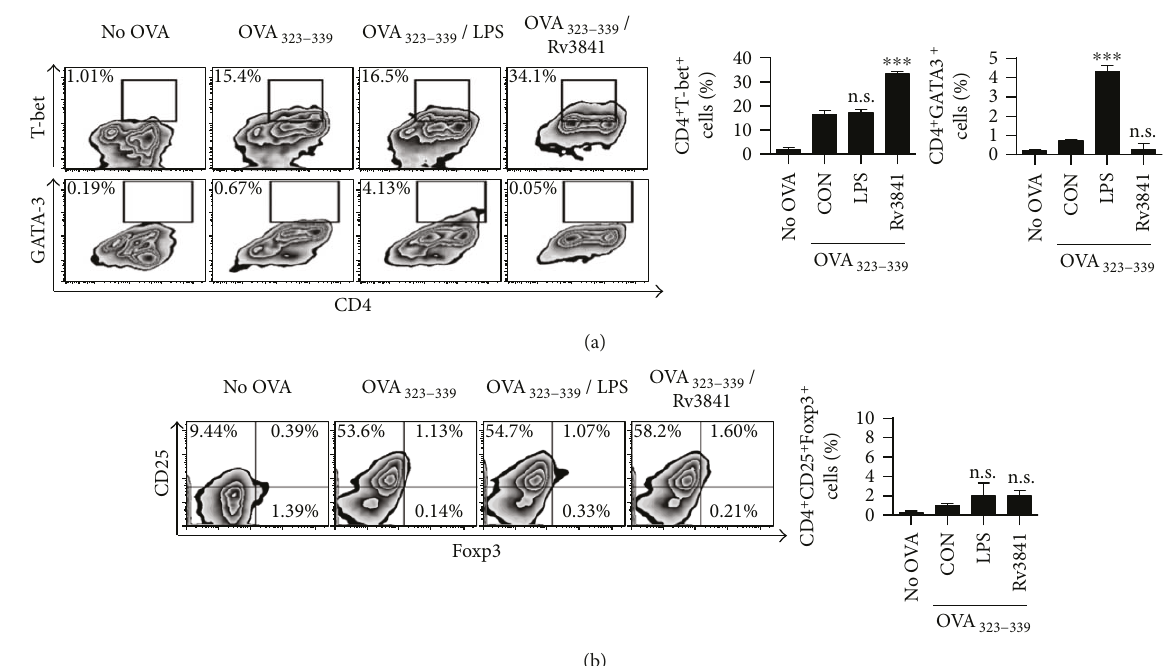
Figure 5: Rv3841-treated DCs stimulate T-cells to di ff erentiate into the Th1 but not Th2 or Treg lineage. Transgenic OVA-speci fi c CD4 + T- cells were isolated using MACS from OT-II mouse splenocytes and were cocultured for 72 h with DCs that were pretreated with Rv3841 (10 μ g/mL) or LPS (100ng/mL) and then pulsed with OVA (1 μ g/mL) to produce OVA-speci fi c CD4 + T-cells. T-cells alone or T- 323 – 339 cells cocultured with untreated DCs served as controls. (a, b) The expression of transcription factors was then assessed using intracellular FACS analysis. The mean values ± SD ( n = 3 ) are shown; ∗∗∗ p < 0 001 : a signi fi cant di ff erence of treatment groups from the appropriate controls (T-cells+OVA -pulsed DCs), as determined by one-way ANOVA. Treatments without a signi fi cant e ff ect are indicated by “ n.s. 323 – 339